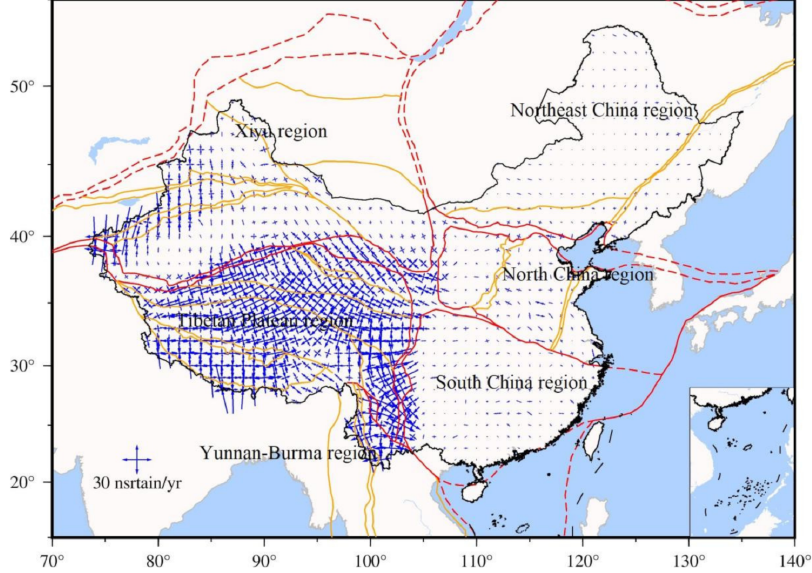
Figure 7. The principal strain rate field in continental China (The red and yellow lines are block boundaries).